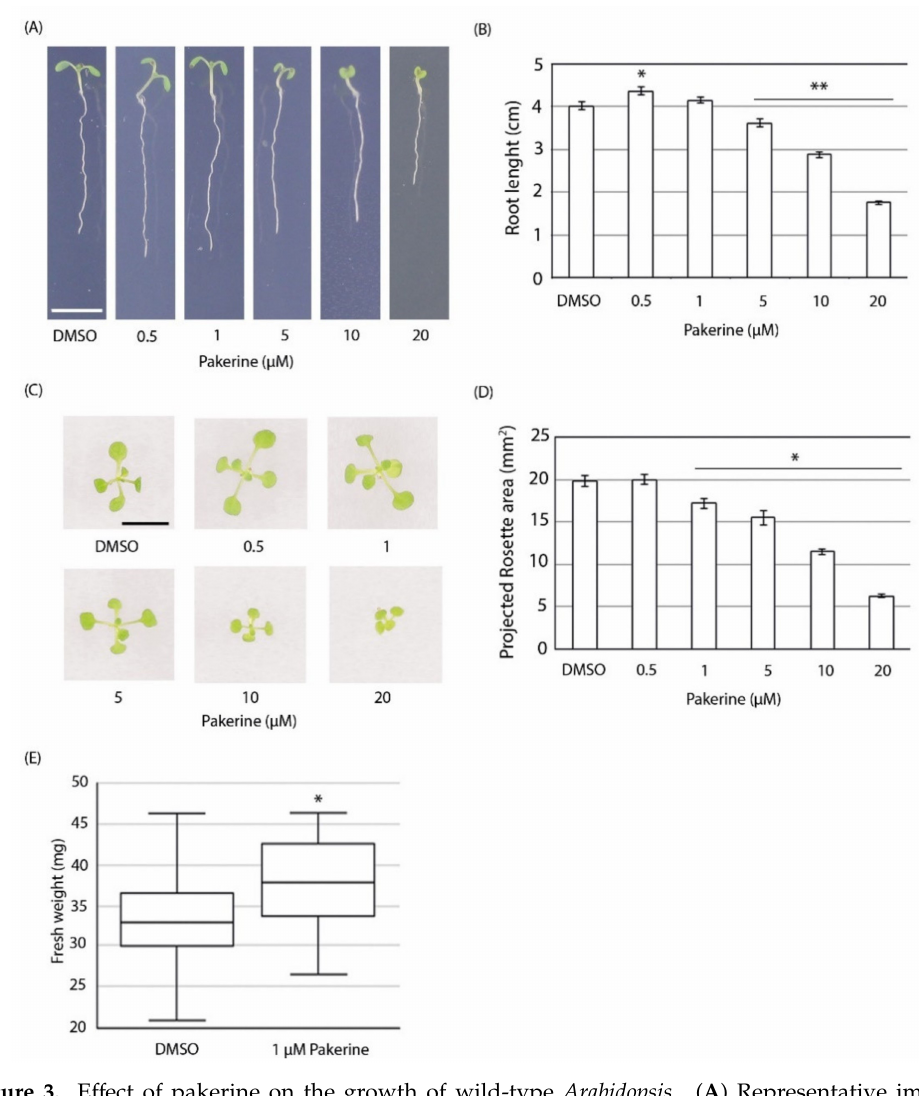
Figure 3. E ff ect of pakerine on the growth of wild-type Arabidopsis . ( A ) Representative images of seven-day-old seedlings grown vertically on MS medium supplemented with di ff erent pakerine concentrations. Control plants were grown on medium supplemented with DMSO. Scale bar = 1 cm. ( B ) Quantification of the primary root length of seedlings ( n = 36) grown on pakerine as described in ( A